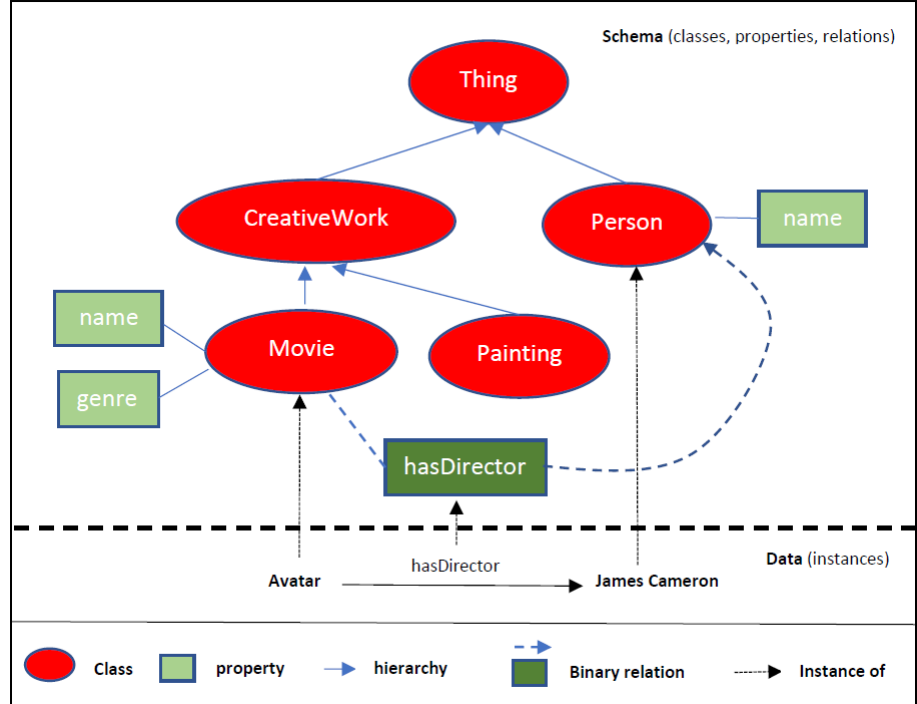
Figure 1. Example